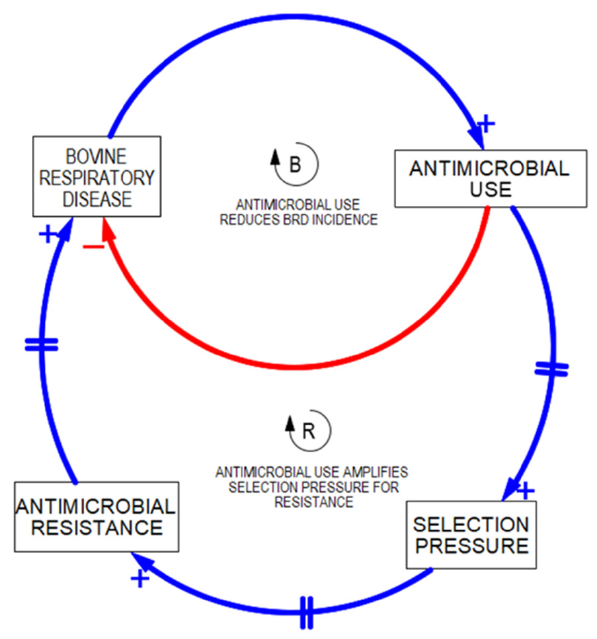
Figure 4. Balancing loop with reinforcing loop demonstrating an unintended consequence.